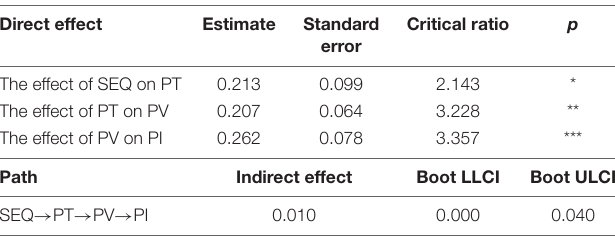
TABLE 7 | Results of path analysis 7.